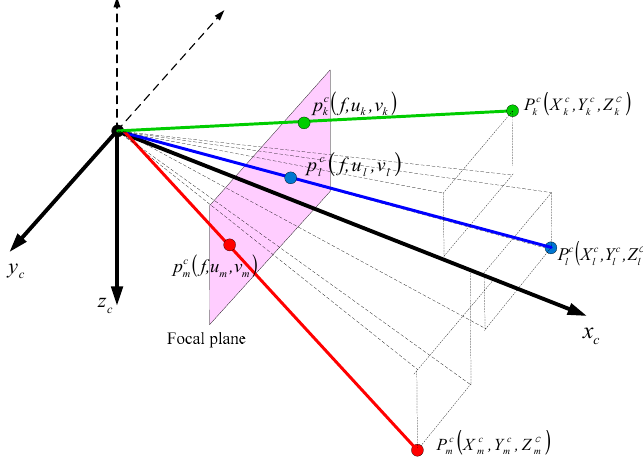
Figure 1. Landmark measurements in the vision navigation.